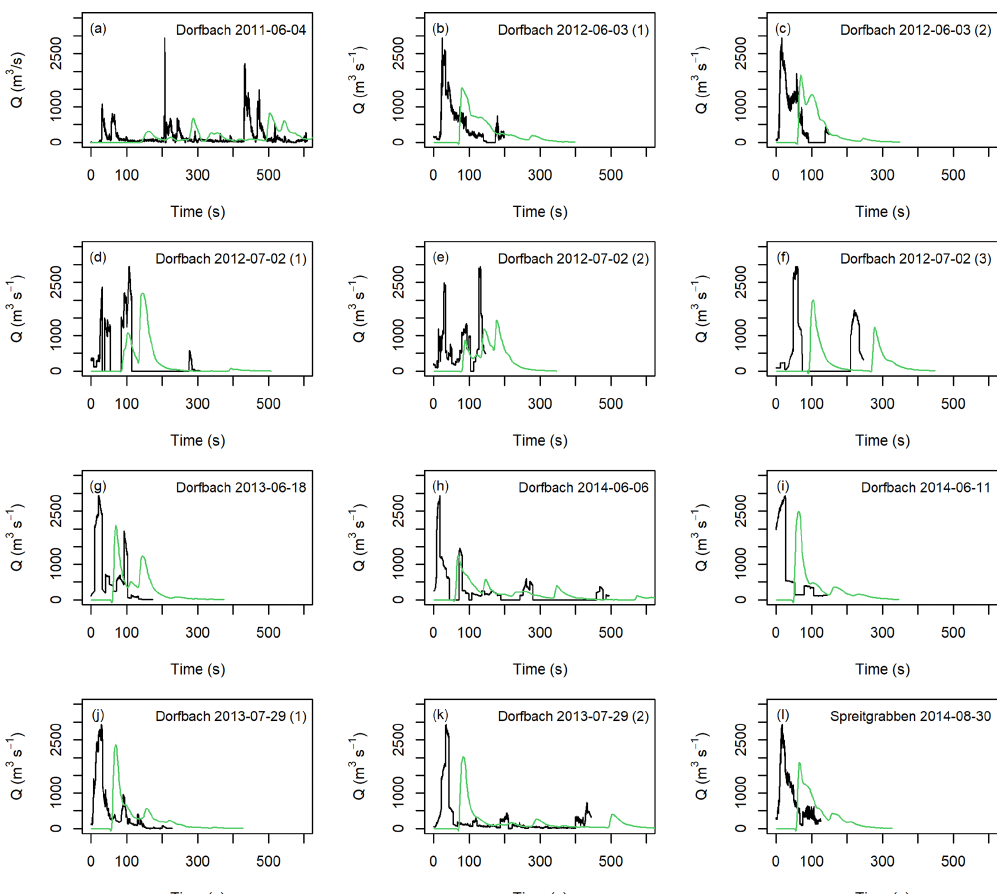
Figure 9. Comparison of input hydrographs (black lines) from the Dorfbach and Spreitgraben sites and extracted hydrographs at x = 1000m in the numerical experiment (green